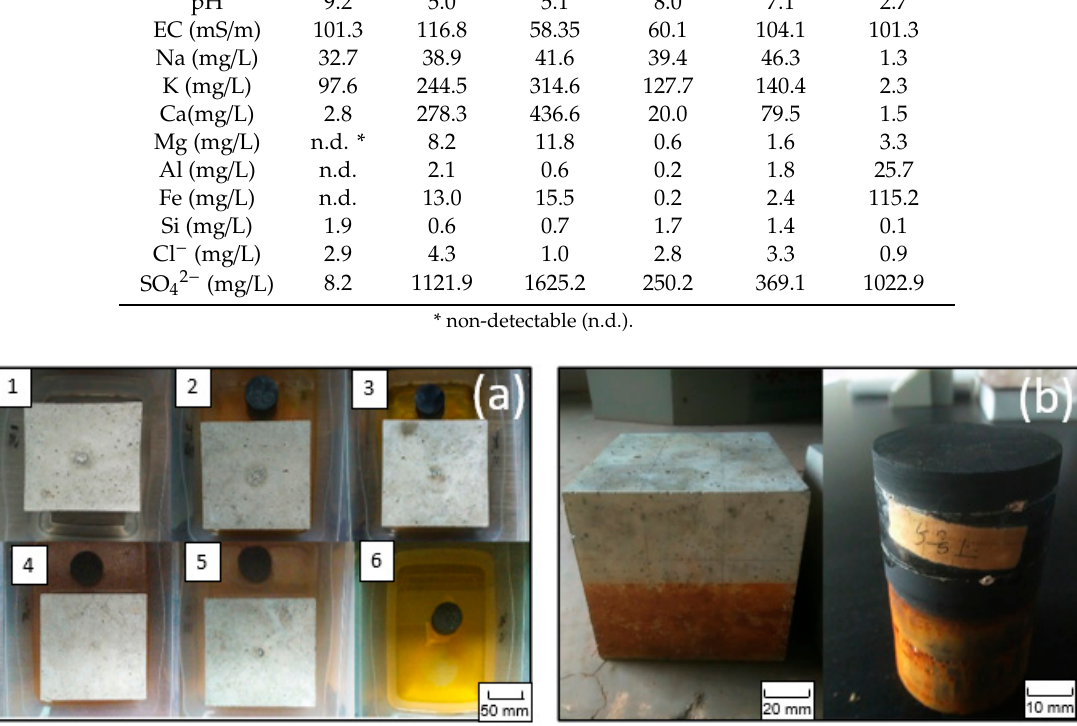
Figure 5. The visible presence of oxidation products ( a ) in the water and ( b ) on the surface of the concrete and black shale. Table 2. Water chemistry of the immersion solution after the 40-day laboratory immersion tests.